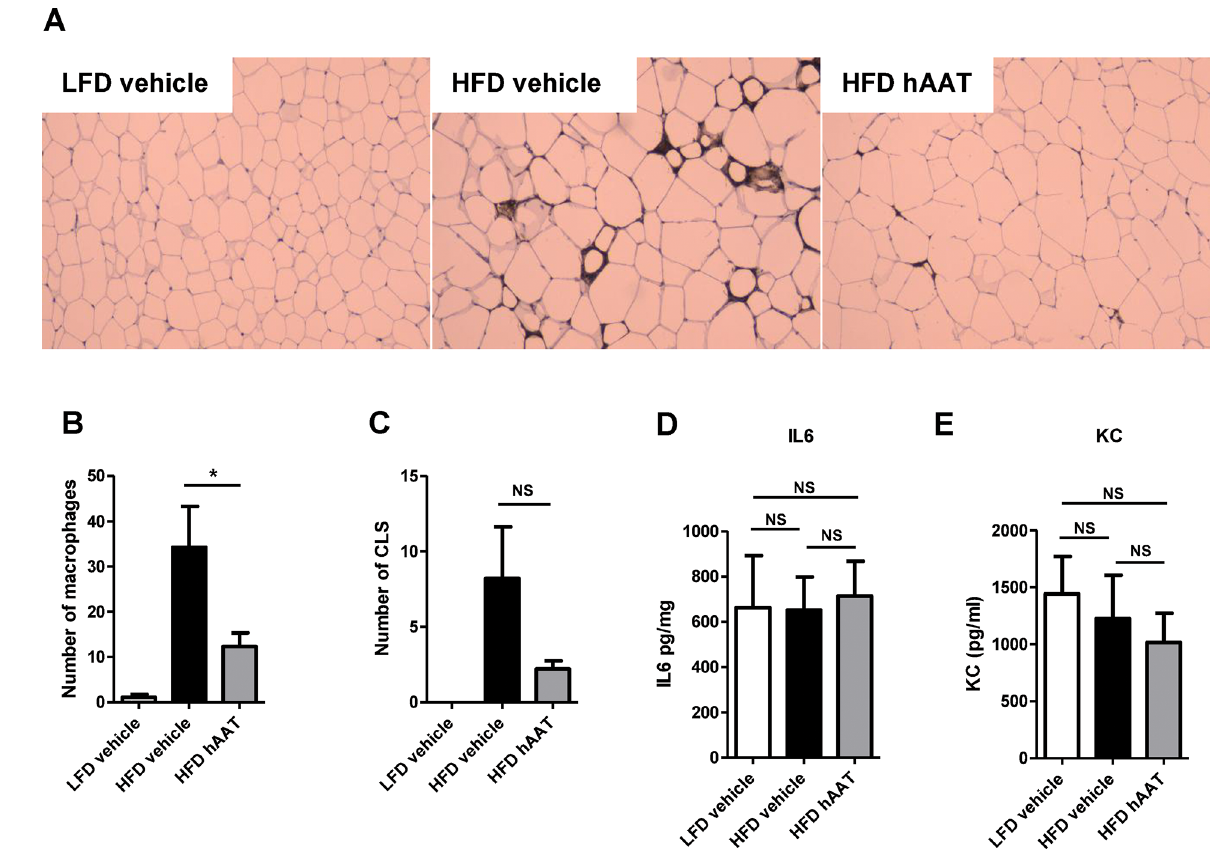
Figure 7. Treatment with human α -1 antitrypsin reduces macrophage infiltration into the adipose tissue during the last 10 d of a high- fat diet. (A) Representative images of immunostaining of the macrophage marker F4/80 in white adipose tissue of low–fat–diet-fed mice treated with vehicle, high–fat–diet-fed mice treated with vehicle and high–fat–diet-fed mice treated with human α -1